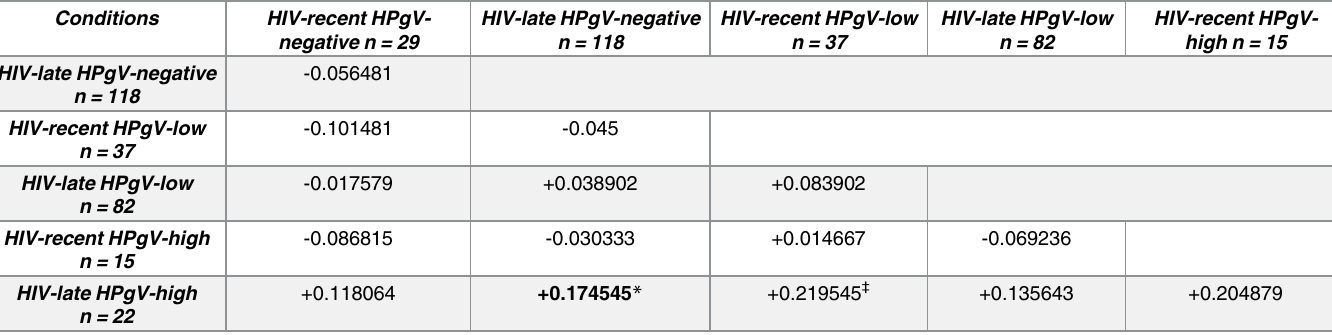
Table 4. Mean difference of CD4 + /CD8 + ratio in co-infected subjects according to time of HIV infection and HPgV viral load condition.